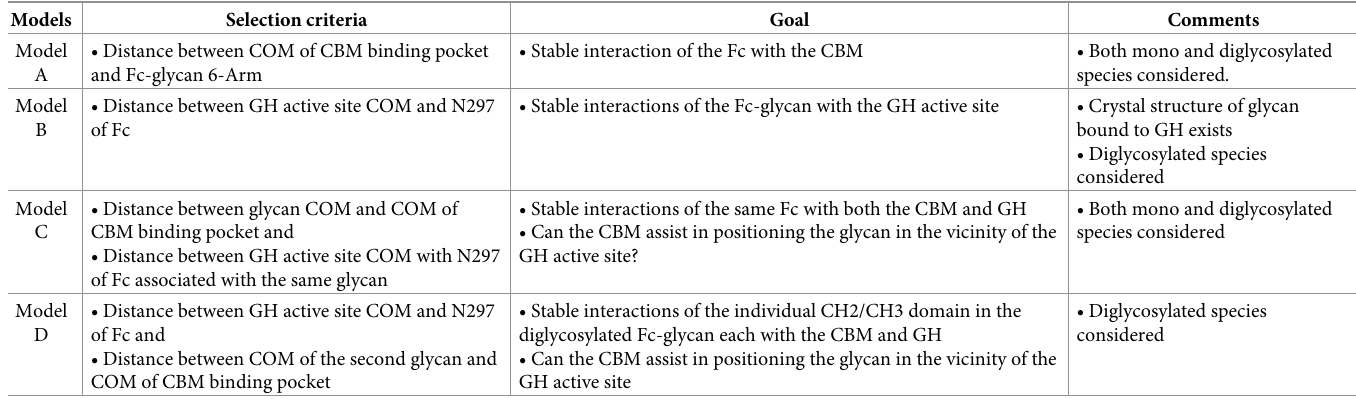
Table 1. Initial model selection criteria and goal of each of the four EndoS2-Fc-glycan models. Models Selection